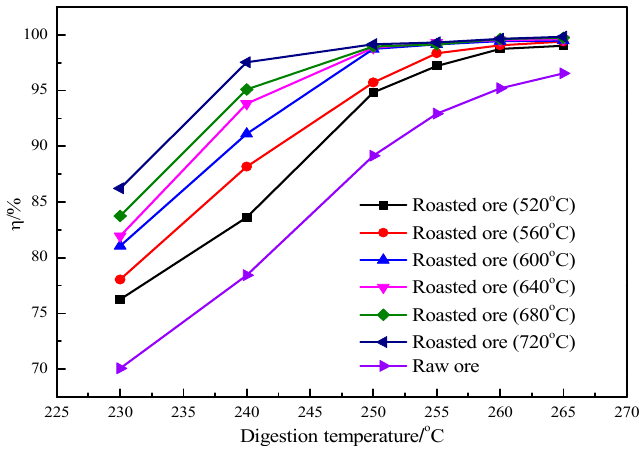
Figure 8. Effect of digestion temperature on the relative digestion rate under the conditions of 60 min digestion time, 9% lime addition, 236 g/L caustic concentration, and 1.50 ingredient molecular ratio.